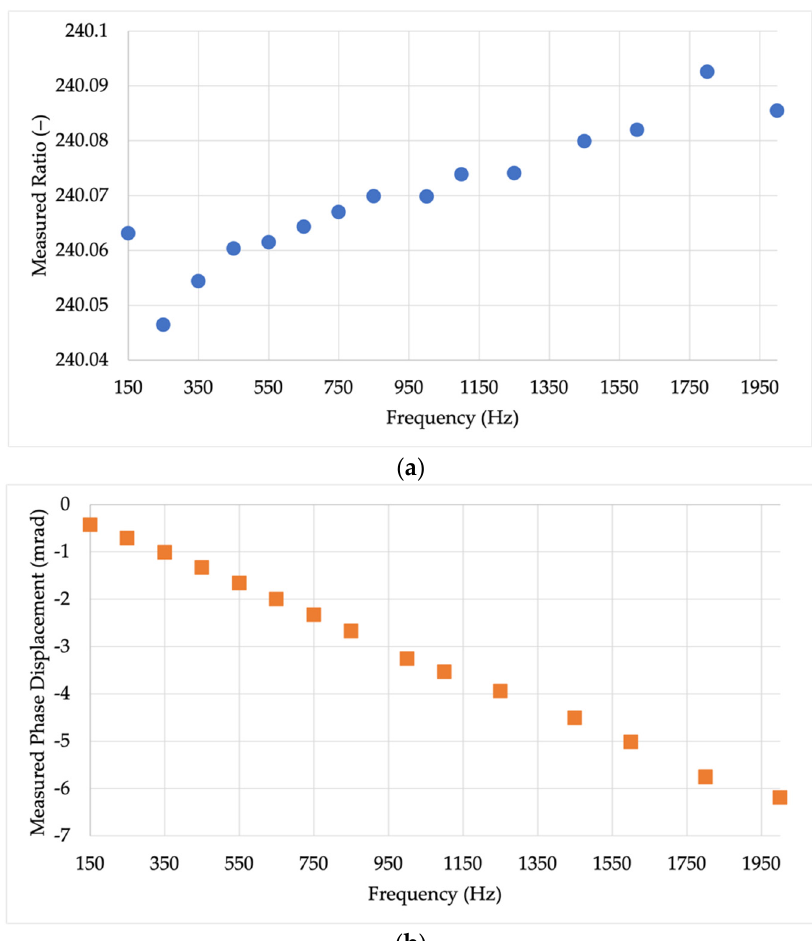
Figure 3. Results of the resistive divider characterization: ( a ) ratio and ( b ) phase displacement.